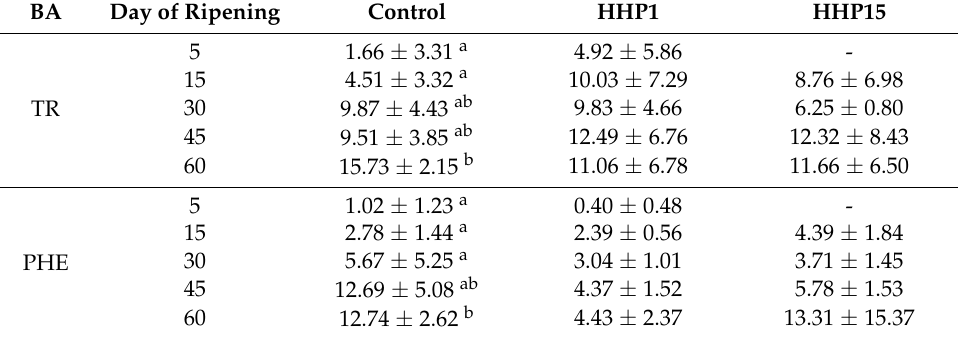
Table 6. Monoamine and diamines content (mean values ± standard deviation expressed as mg/kg in dry basis) formed during the ripening of ewes’ raw milk cheese samples with and without HHP